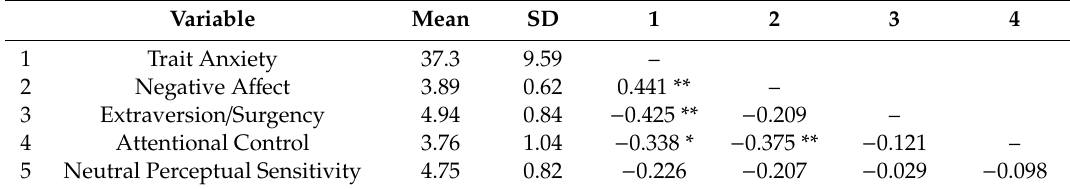
Table 4. Descriptive Statistics and Intercorrelations for Trait Anxiety and ATQ Scales.